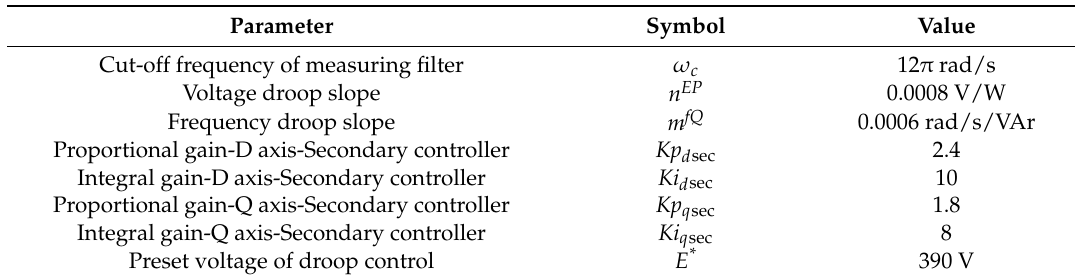
Table 1. Parameters of primary and secondary